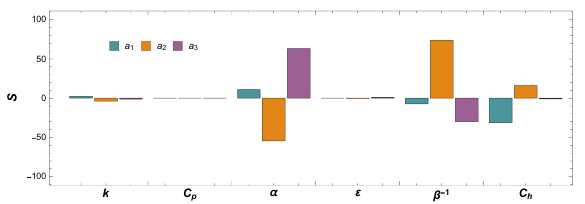
Figure 2. Relative variation in sensitivity ( S , %, Eq. 28) to surface parameters. See Fig. 1 for further